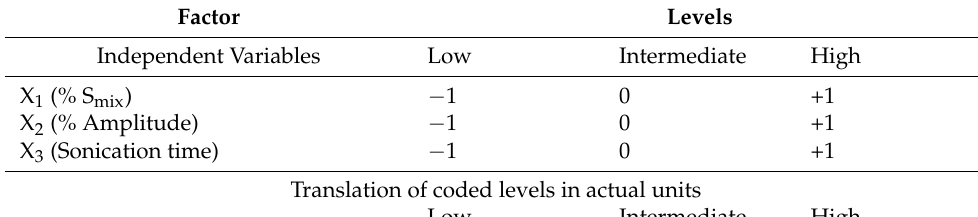
Table 1. The Box–Behnken design showing variables of the nano-emulsification procedures. Factor Levels Independent Variables Low Intermediate High